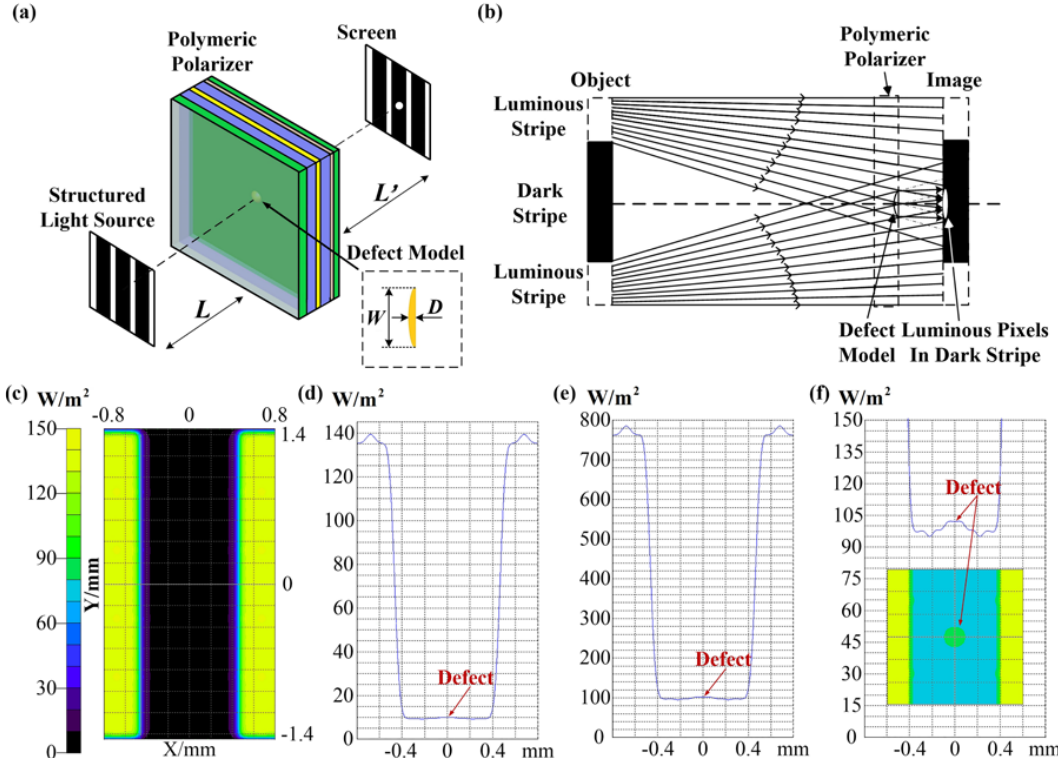
Figure 1. ( a ) Schematic of a TracePro simulation system; ( b ) saturated imaging mechanism for defects; ( c ) simulation result of light distribution on the screen; ( d ) light intensity along the zero axis in the horizontal directions; ( e ) higher light intensity along the zero axis in the horizontal directions; ( f ) light intensity after light intensity greater than 150 W/m 2 was eliminated, the inserted image represents the light distribution on the screen under this condition. D = 0.01 mm, W = 0.4 mm, L = 29.846 mm, L’ = 0.923 mm.